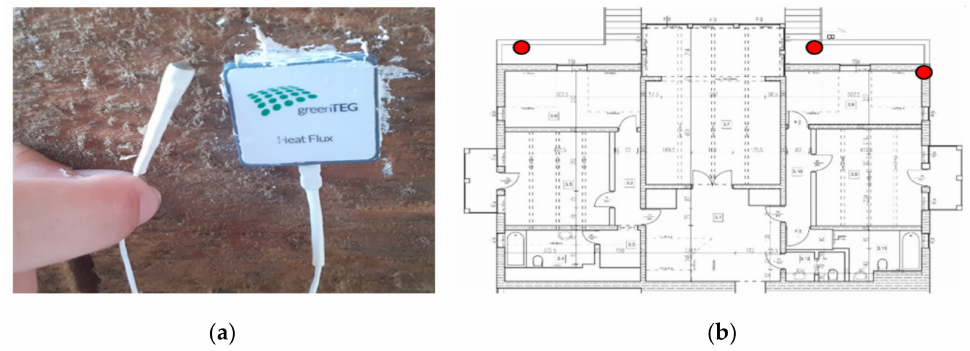
Figure 8. Measurement of the thermal transmittance coe ffi cient in wooden log walls ( a ) with locations of measurement equipment marked on a part of the building plan ( b